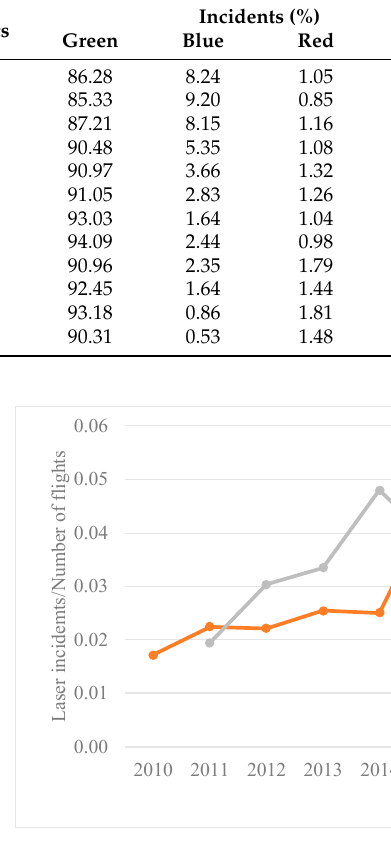
Figure 1. Ratio of the number of incidents with the laser to the total number of flights in the USA and Poland. Own elaboration based on data from [29,30].